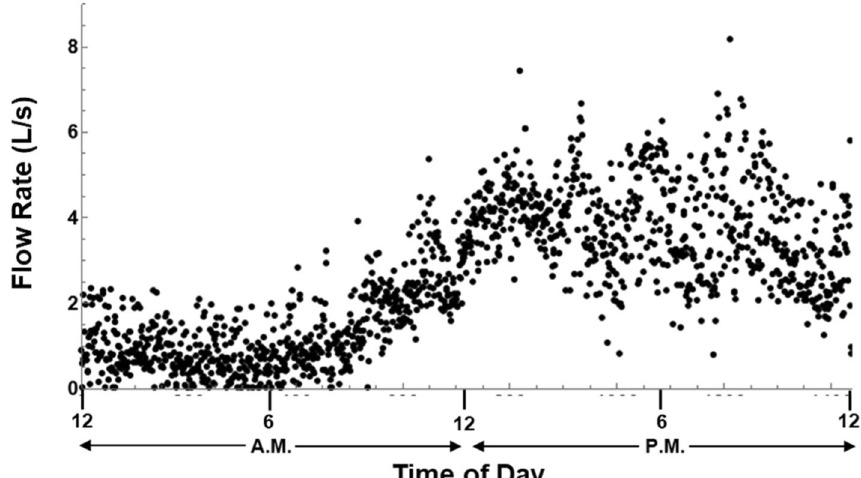
Fig. 9 Monday average readings for daily flow